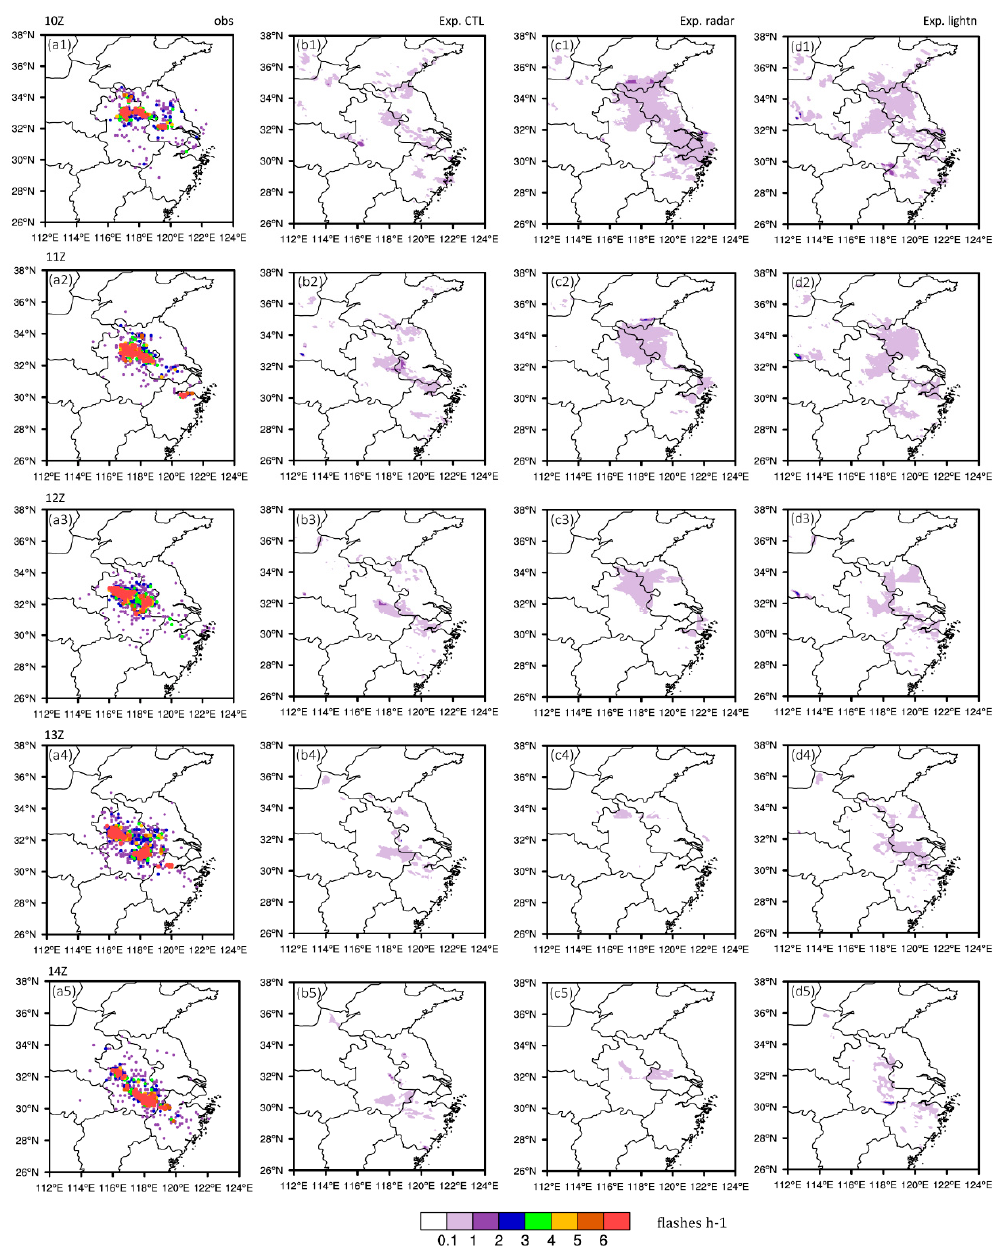
Figure 4. The observed cloud-to-ground lightning rate (unit: flashes · h − 1 ) ( a ) and forecast accumulated cloud-to-ground lightning rate (unit: flashes · h − 1 ) of ( b ) Exp. CTL, ( c ) Exp. radar and ( d ) Exp. lightn hourly from 0900 to 1400 UTC. Row 1 to 5 represents different time point from 0900 to 1400 UTC.